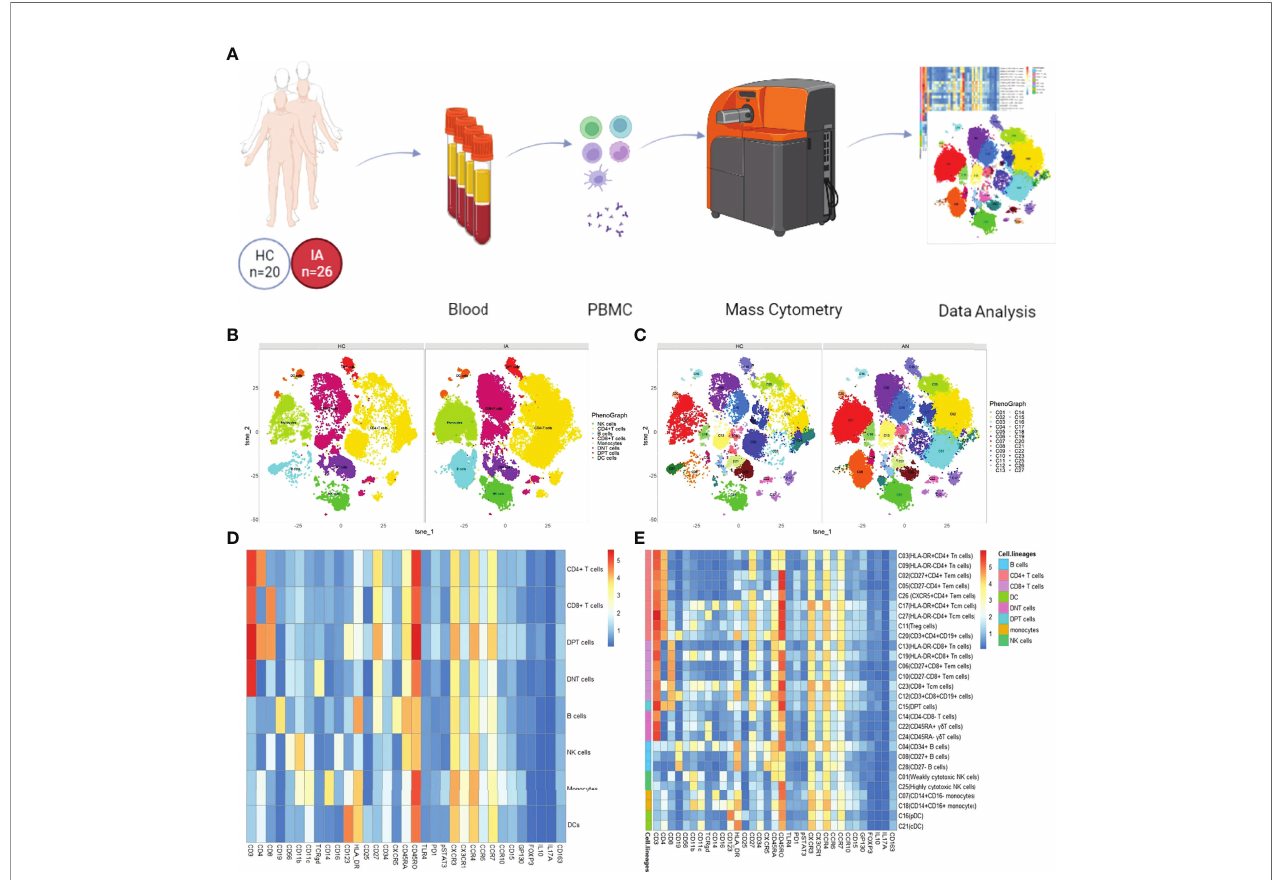
FIGURE 1 | Overview of the imaging mass cytometry study of IA. (A) Flowchart overview of PBMC collection. Twenty-six PBMC samples from IA patients were included in this study, as well as 20 control samples. PBMCs were stained with one antibody panels and acquired on the CyTOF instrument. (B) t-SNE visualization of CD45+ cells from PBMCs. PhenoGraph clusters analysis of manual gated eight-cell lineages, including CD4 + T cells, CD8 + T cells, CD4 + CD8 + double-positive T cells (DPT), CD4 - CD8 - double-negative T cells (DNT), B cells, NK cells, dendritic cells (DCs), and monocytes. (C) Representative t-SNE plot of 28 cell clusters from HC and IA patients:CD4 + T cells, nine clusters (C02, C03, C05, C09, C11, C17, C20, C26, C27); CD8+T cells, six clusters (C06, C10, C12, C13, C19, C23); DPT, one cluster (C15); DNT, three clusters (C14, C22, C24); B cells, three clusters (C04, C08, C28); NK cells, two clusters (C01,C25); monocytes, two clusters (C07,